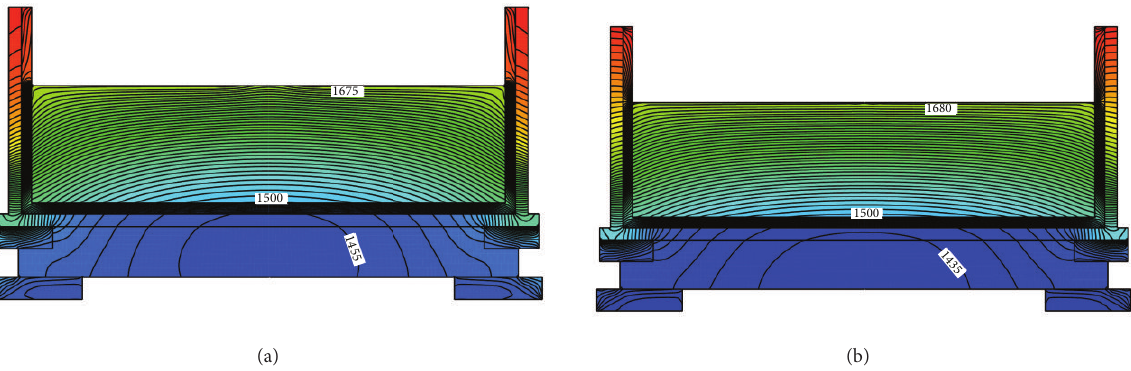
Figure 6: Temperature distribution (5 K between two isotherms) before melting of feedstock in evolved DS furnace for different power distribution ratios: (a) 5 :5; (b)